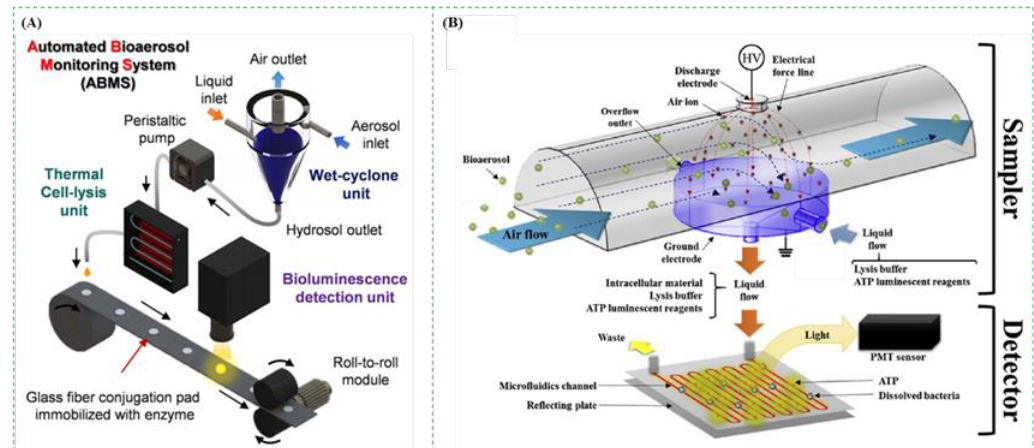
Figure 9. ( A ) The ATP-based bioluminescence assay for real-time detection of the bioaerosols. Reprinted with permission from ref. [47]. Copyright 2020 American Chemical Society. ( B ) The ATP-based bioluminescence assay on microfluidic chip for detection of the bacterial bioaerosols. Reprinted with permission from ref. [34]. Copyright 2016 Elsevier B.V. Table 1. Comparison of bioaerosol detection methods.